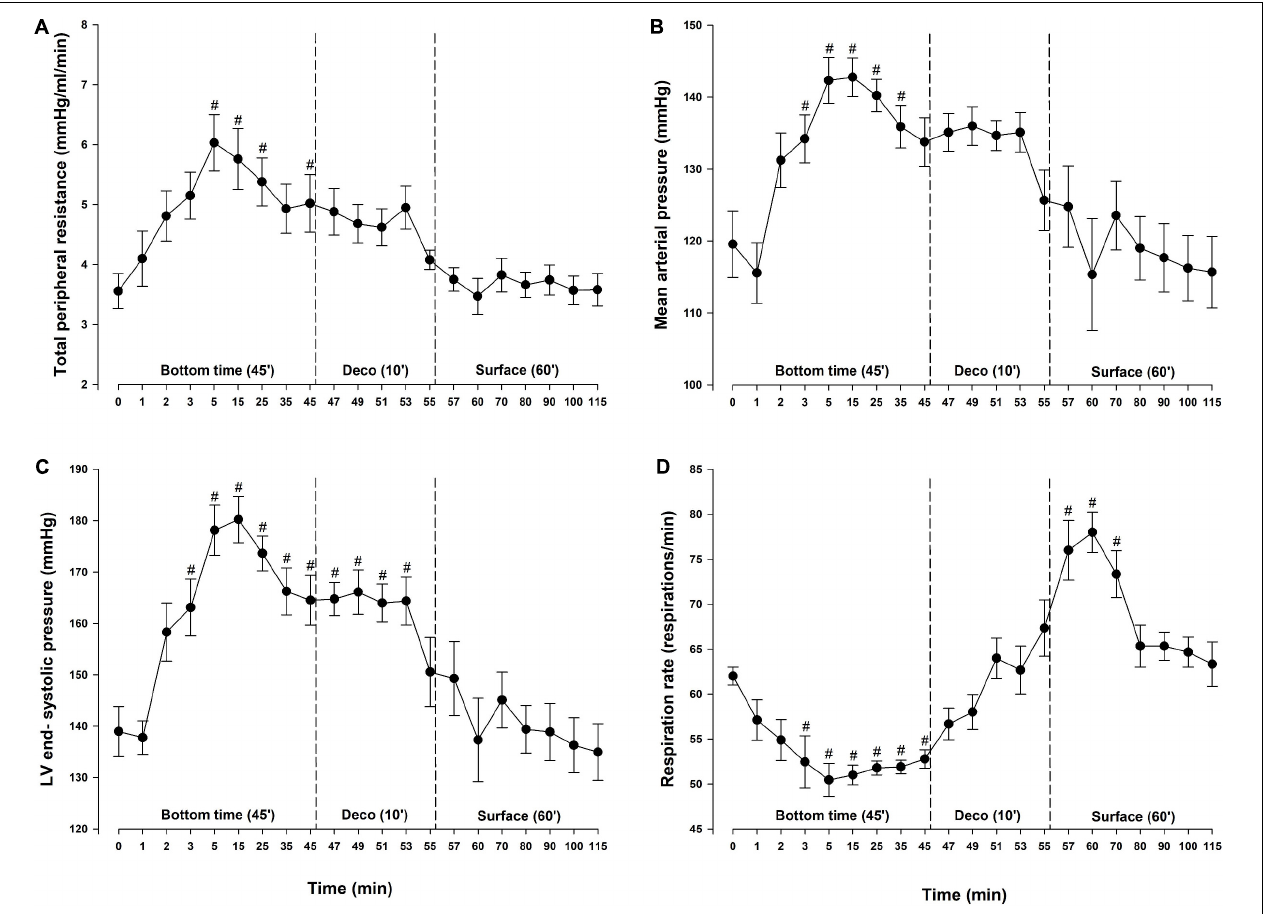
FIGURE 2 | Determinants of cardiac afterload and respiration. (A) Total peripheral resistance (TPR), (B) mean arterial pressure (MAP), (C) left ventricular (LV) end-systolic pressure and (D) respiration rate (RR) in rats exposed to simulated diving ( n = 9). Data were assessed using one-way repeated measures ANOVA for normal distributed variables and Friedman repeated measures ANOVA on ranks for non-normal distributed variables. Values are mean ± SEM. # p < 0.05 compared to intragroup baseline.